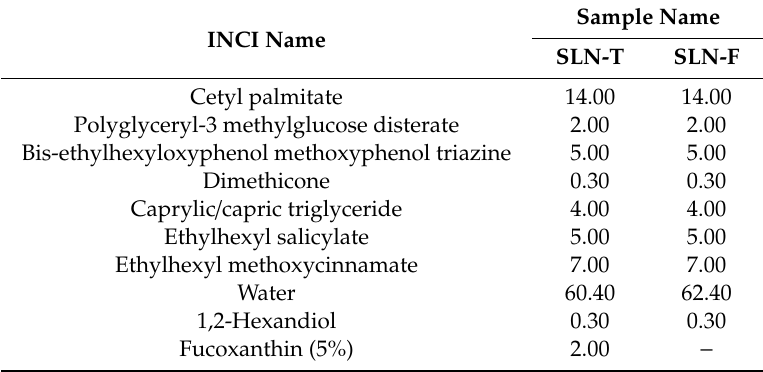
Table 3. A formulation of SLN samples, including general sunscreen agents for comparing SPF (SLN-T: samples with ethylhexyl methoxycinnamate, bis-ethylhexyphenol methoxyphenol triazine, ethylhexyl salicylate, and fucoxanthin; SLN-F: samples with ethylhexyl methoxycinnamate, bis-ethylhexyphenol methoxyphenol triazine, and ethylhexyl salicylate).